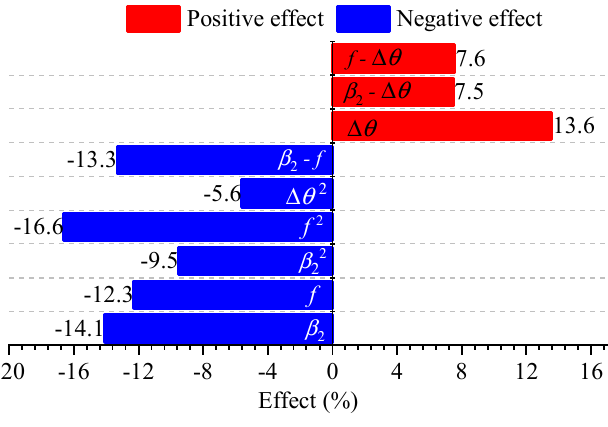
Figure 14. Pareto chart for ANOVA.